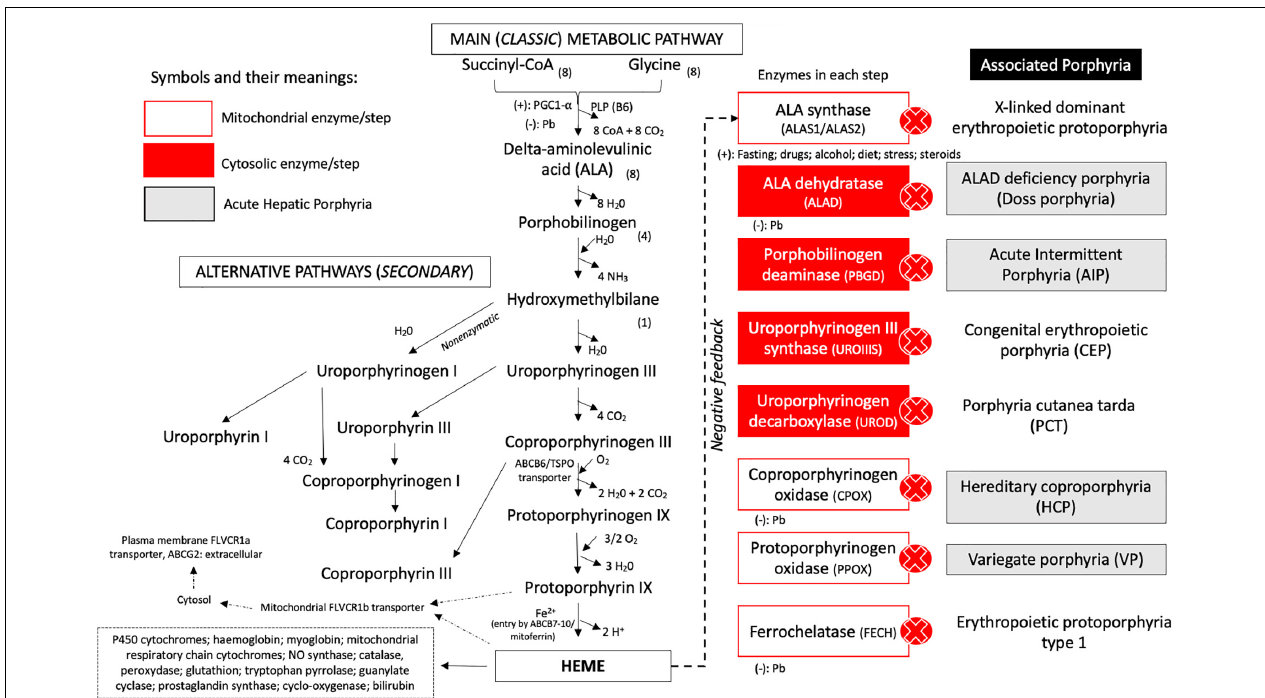
FIGURE 1 | Metabolic pathways and steps of heme group biosynthesis and correlation of enzyme deficiency and associated porphyria. The classic and alternative pathways associated with heme biosynthesis are presented with the specific transporters, cofactors, and reagents involved in each chemical reaction. The enzymes involved in each step of biosynthesis are represented at the right side of the metabolic route. After the heme group has been produced, it promotes downregulation of ALA synthase and can be incorporated by mitochondrial hemoproteins or leave the mitochondrial compartment by the FLVCR1b transporter and come to the cytoplasm to be incorporated by several compounds. In the plasma membrane, the ABCG2/FLVCR1a transporter is present and can regulate the efflux of the heme group. Acute hepatic porphyria (AHP) types are presented in gray boxes. Cytosolic steps are represented in red boxes, and intramitochondrial enzymes are presented in white boxes. Legend: ALA, delta-aminolevulinic acid; CoA, coenzyme A; NO, nitric oxide; (–), inhibition (downregulation) of the enzymatic step; (+), upregulation (stimulation) of the